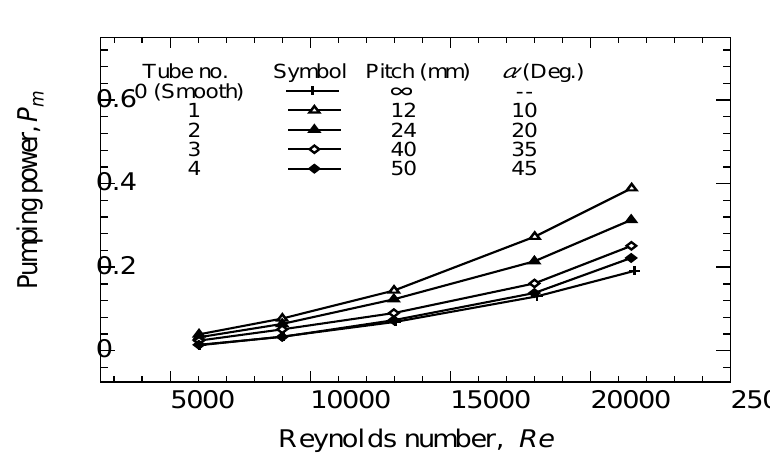
Figure 5: Variation of average pumping power against Reynolds number for smooth tube and wire-coil inserted tubes.